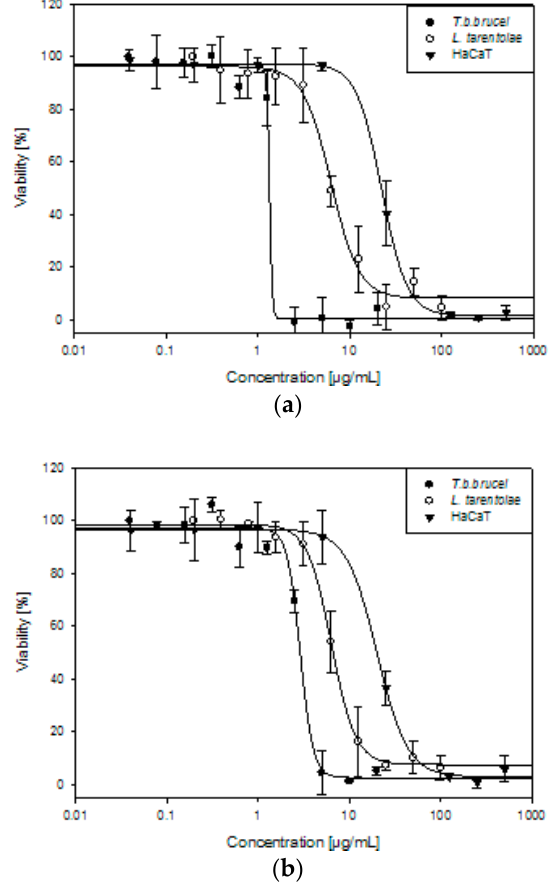
Figure 4. Trypanocidal, leishmanicidal, and cytotoxic effects of ( a ) Allium ursinum and ( b ) Tulbaghia violacea against Trypanosoma brucei brucei ( T. b. brucei ), Leishmania tarentolae ( L. tarentolae ), and HaCaT. Data illustrate the mean of three individual experiments.